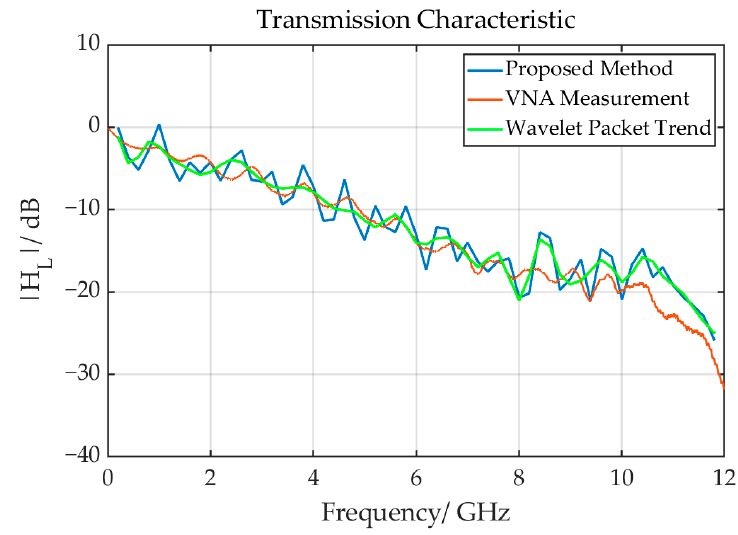
Figure 15. The transmission characteristic of the trace from port 5 to port 6 obtained by the proposed method and smoothed by wavelet packet were compared with measured by a VNA.